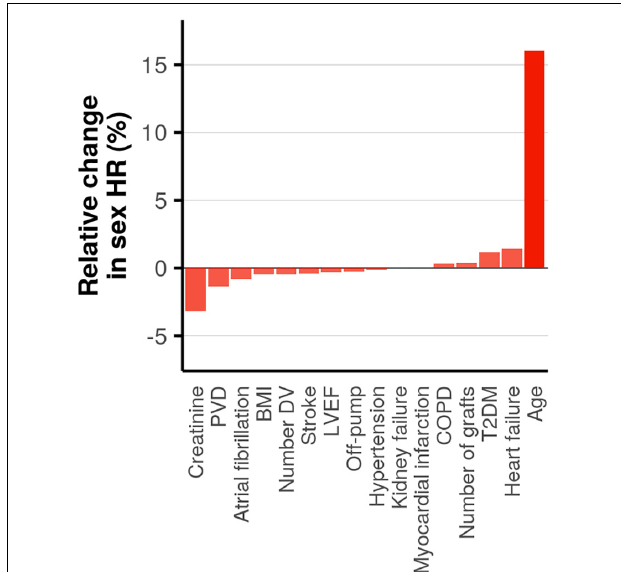
FIGURE 4 | Assessing mediation by estimating the change in the hazard ratio (HR) for female sex on post-CABG survival when removing a covariate. Ordered from small to large, with opacity based on magnitude of